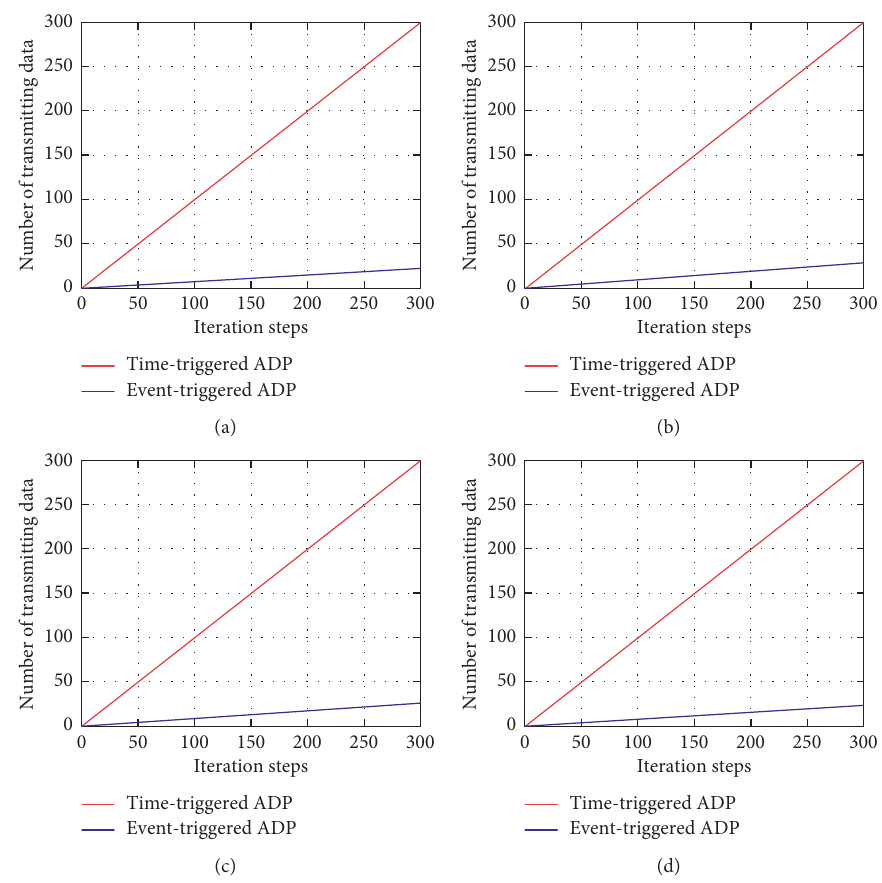
Figure 6: Comparisons of required number of transmitting data under the time-triggered and event-triggered ADP for every agent in the system. (a) The required number of transmitting data under the time-triggered ADP and event-triggered ADP for agent1. (b) The required number of transmitting data under the time-triggered ADP and event-triggered ADP for agent2. (c) The required number of transmitting data under the time-triggered ADP and event-triggered ADP for agent1. (d) The required number of transmitting data under the time- triggered ADP and event-triggered ADP for